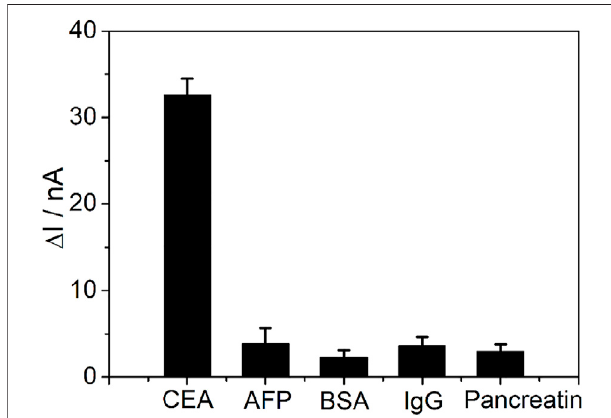
FIGURE 6 | SWV calibration plot of Pt μ E/Au aptasensors recorded for 0.1 μ g ml − 1 CEA, 1 μ g ml − 1 AFP, 1 μ g ml − 1 BSA, 1 μ g ml − 1 pancreatin, and 1 μ g ml − 1 human IgG.